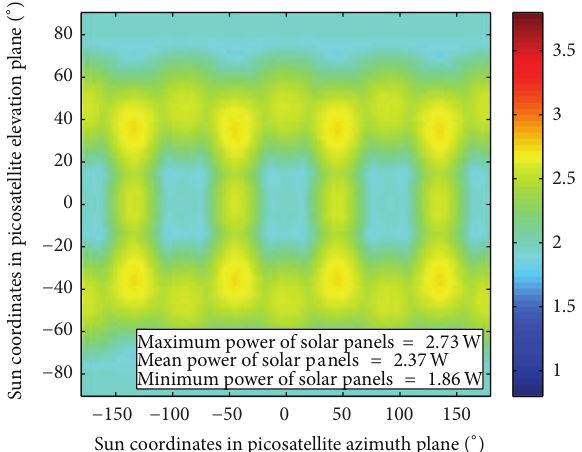
Figure 5: Power generation of gallium arsenide based solar panels placed on CubeSat walls—angle efficiency dependence is covered, 25 ∘ C default temperature of solar cell.